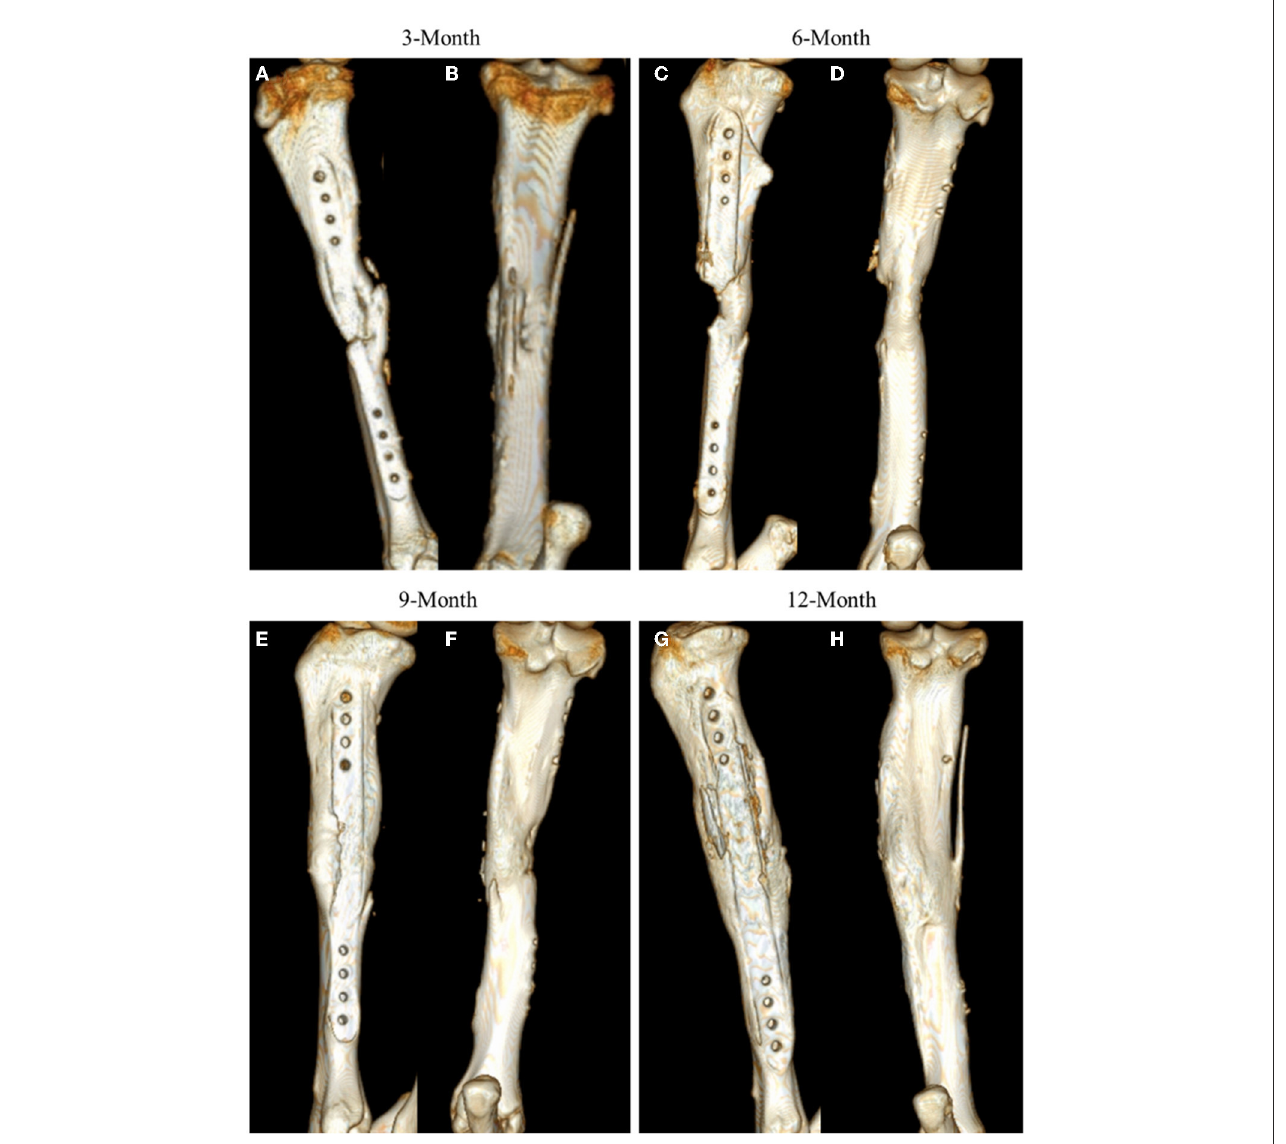
FIGURE3 Representative CT 3D renderings for samples at 3-, 6-, 9-, and 12-month time points. CT renderings are displayed in medial facing (A, C, E, G) and posterior facing (B, D, F, H) angles to highlight mineral content at the